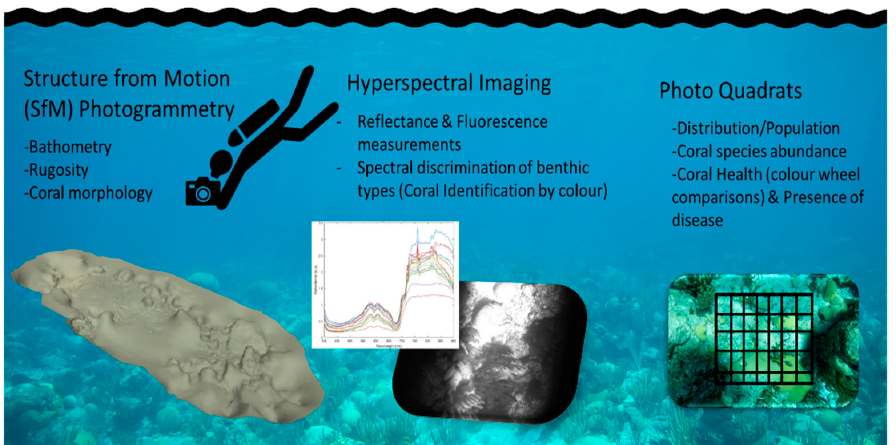
Figure 3. Diver image based techniques and examples of the types of data produced from the main techniques.